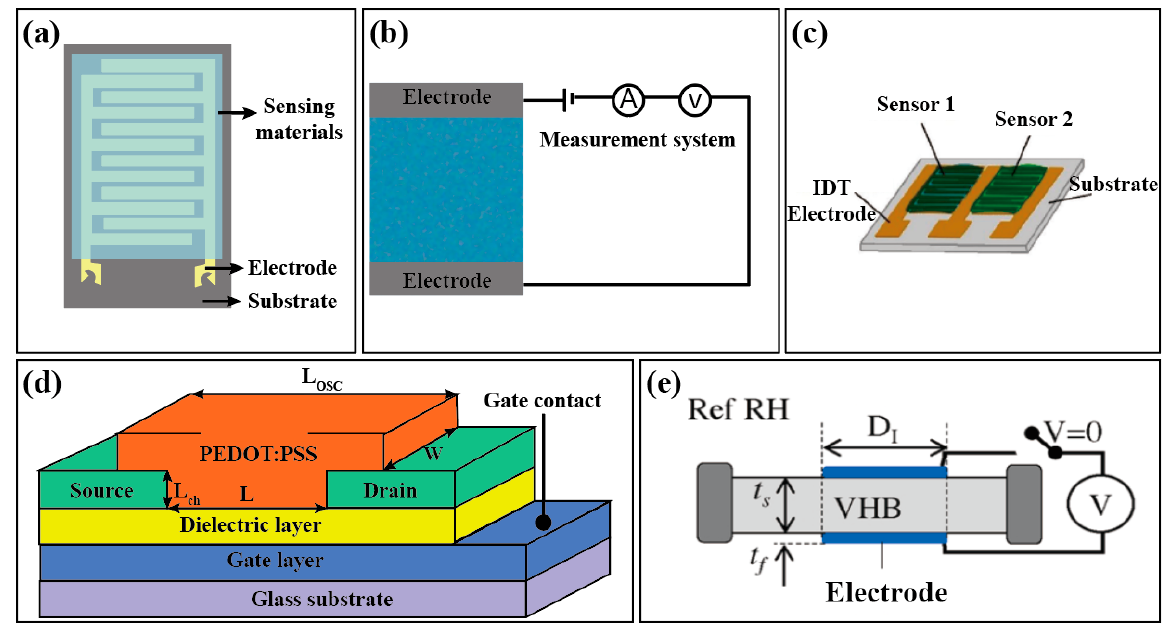
Figure 6. Schematic architectures of electronic chemosensors based on PEDOT:PSS and its composites as sensing materials: ( a ) Simple IDT; ( b ) Electrode-based sensors; ( c ) multiple IDTs in series [64]; ( d ) Organic field effect transistor (OFET); ( e ) Dielectric elastomer actuator [65].